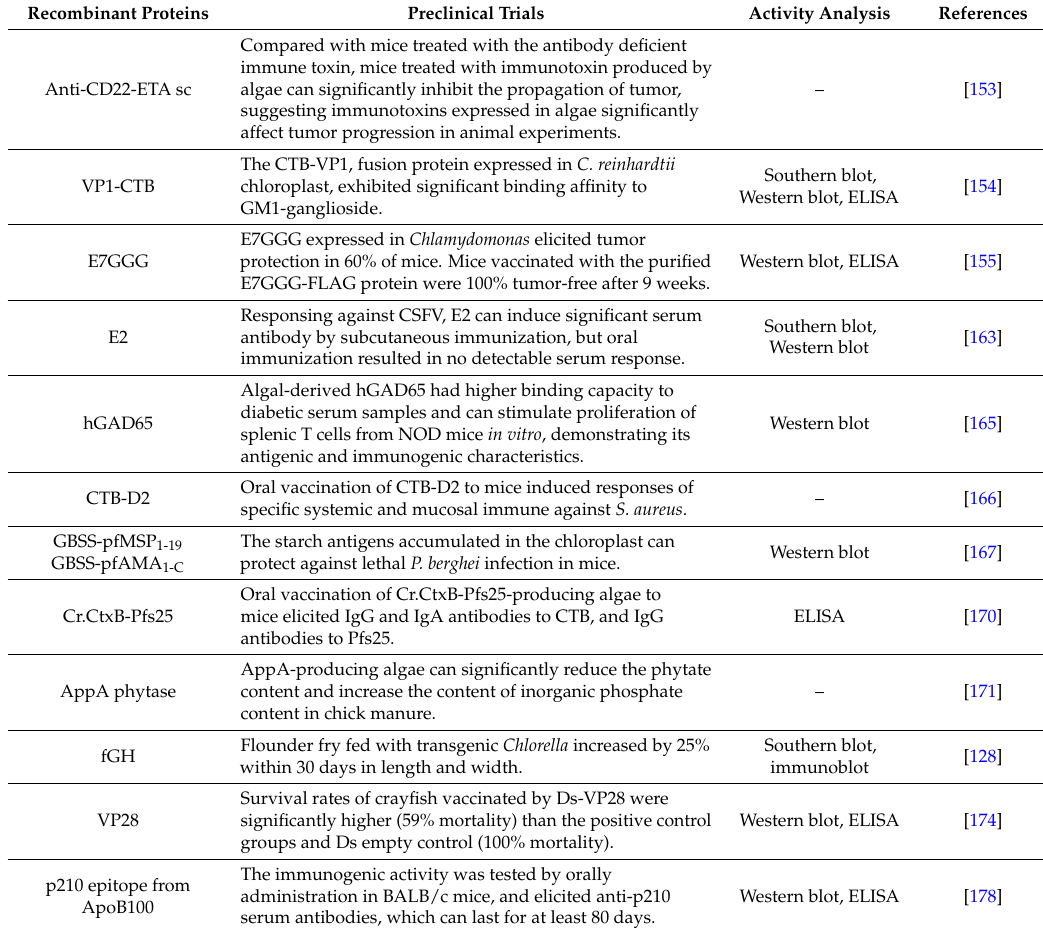
Table 4. Preclinical trials of recombinant proteins expressed in